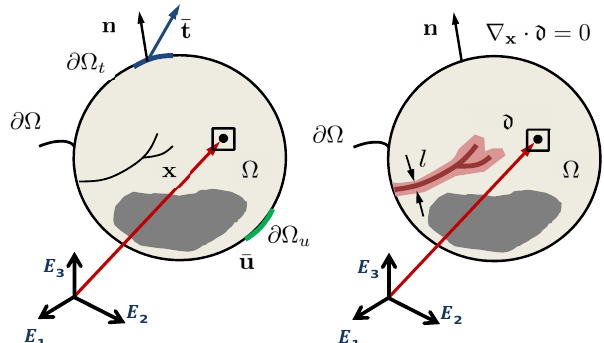
Figure 1. Regularization of the sharp crack topology within the spirit of the phase field approach for